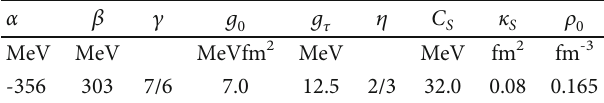
Table 1: The IQ2 parameters used in ImQMD